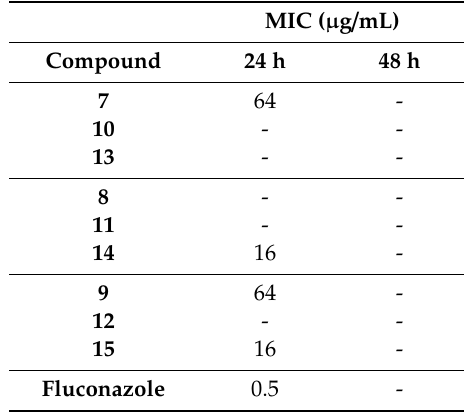
Table 4. Anti- Candida albicans activity of synthesized compounds. The results are representative of incubations arranged in triplicate at 24 and 48 h and the average values were taken as the minimal inhibitory concentrations (MICs).